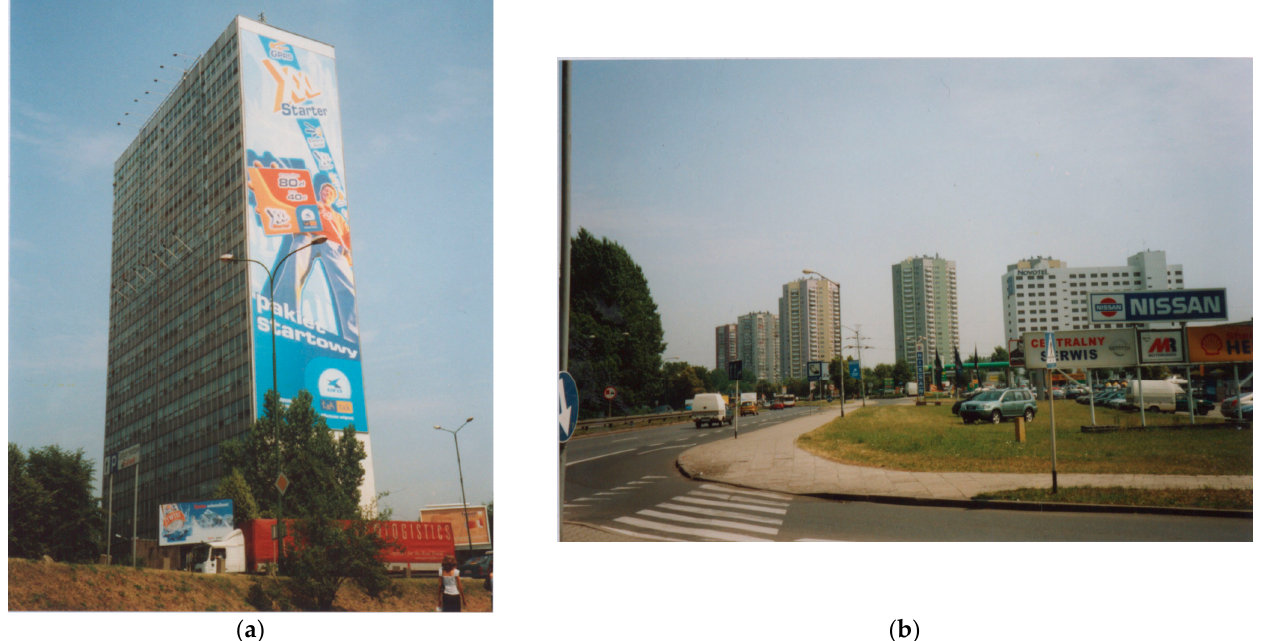
Figure 10. High-rise buildings in the neighborhood of the works in progress: ( a ) big office building; ( b ) residential buildings of the “Stars” estate.